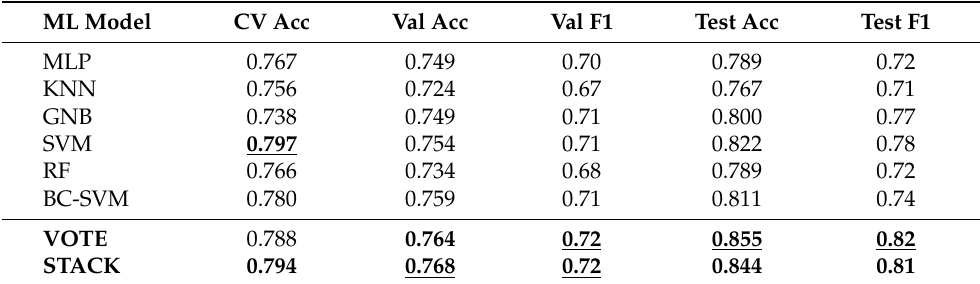
Table 5. The performance of models during the cross validation (CV) parameter selection, on the validation set, and on the test set of data from Tripoli. The best two models for each performance are in bold typeface, and the best underlined.